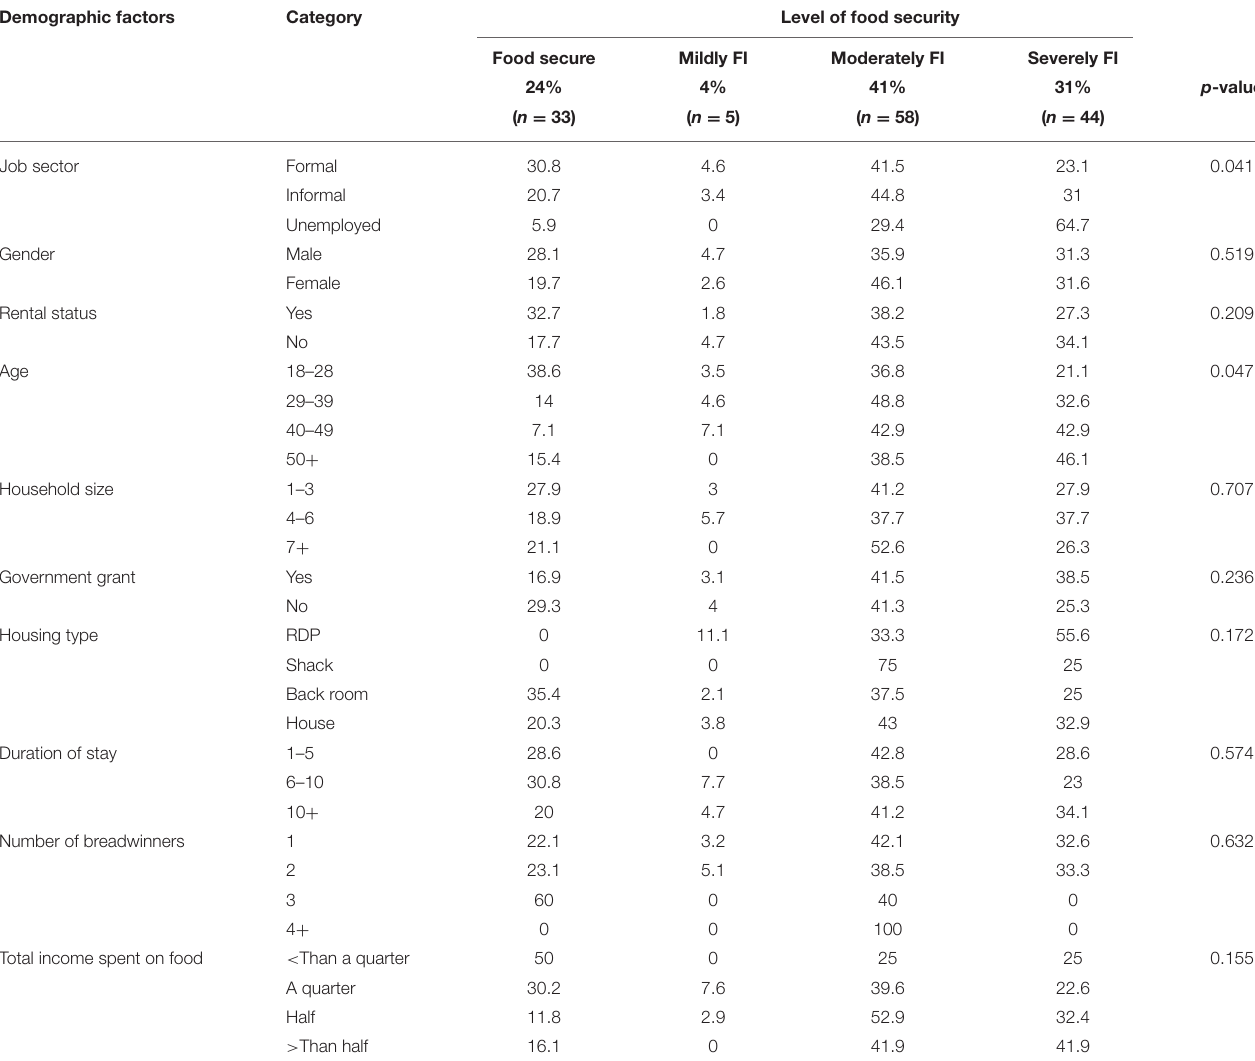
TABLE 1 | Summary statistics of the relationship between household food security status (based on Household Food Insecurity Access Scale) and demographic data of the study population, using the Chi-square statistical test. Demographic